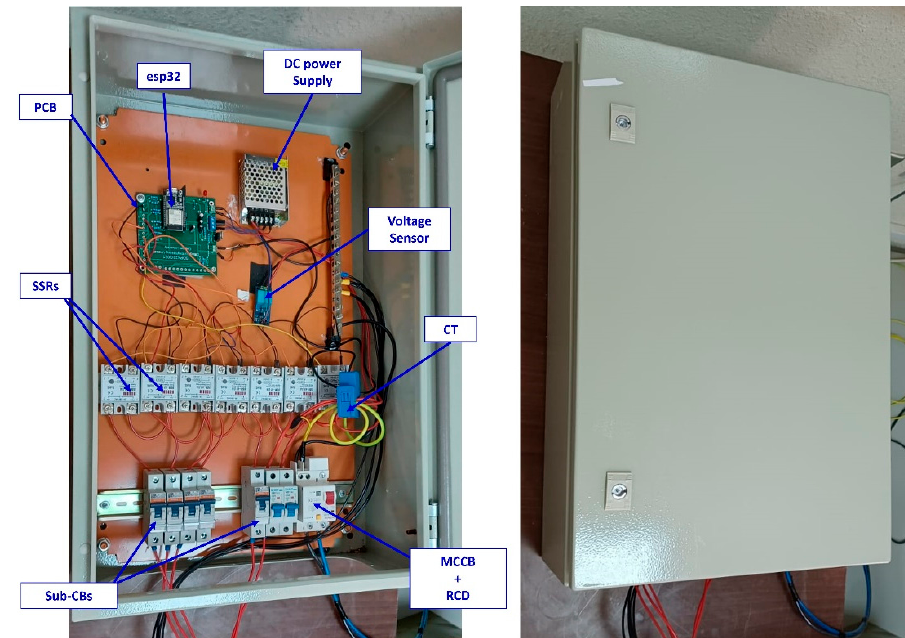
Figure 1. Proposed architecture of the smart DPB.